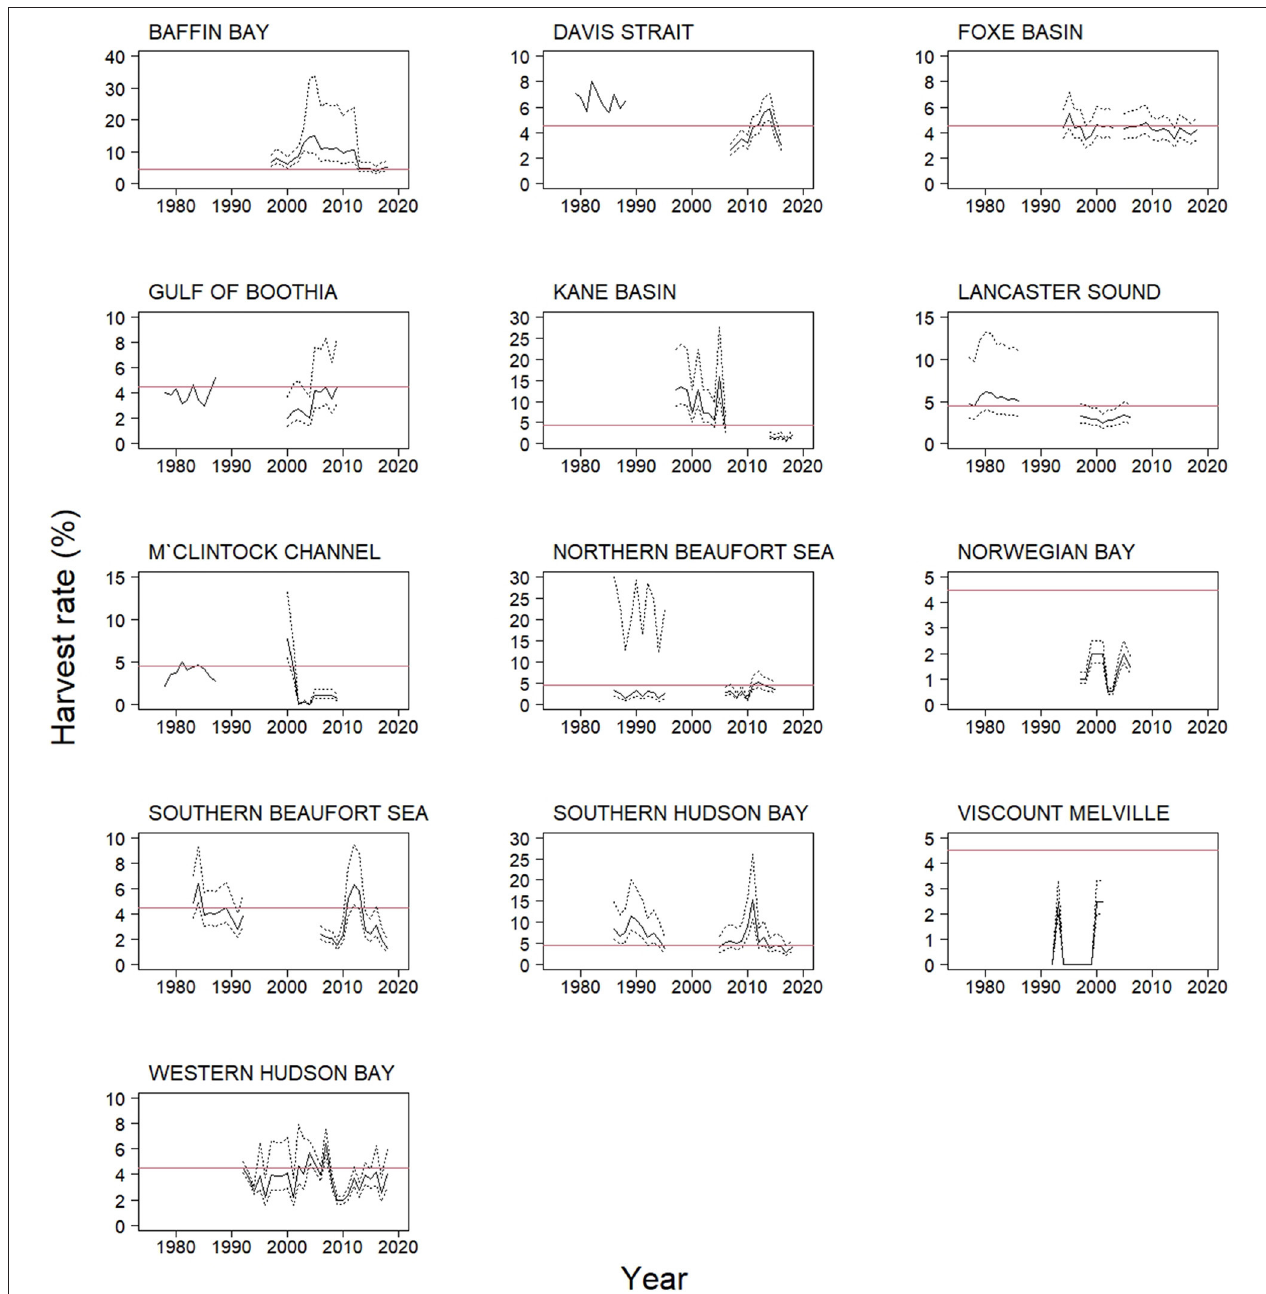
FIGURE 4 | Harvest rates for 13 of 19 polar bear populations in 1970–2018, calculated from total harvest and population estimate ≤ 10 years old reported with 95% confidence intervals shown by dotted lines. Solid red line is the 4.5% harvest level, which has been suggested as the maximum sustainable harvest level. Six populations are excluded: Arctic Basin, Kara Sea, and Laptev Sea have no population estimate or legal harvest, Barents Sea has no harvest, East Greenland has no population estimate, and Chukchi Sea due to lack of Russian data.